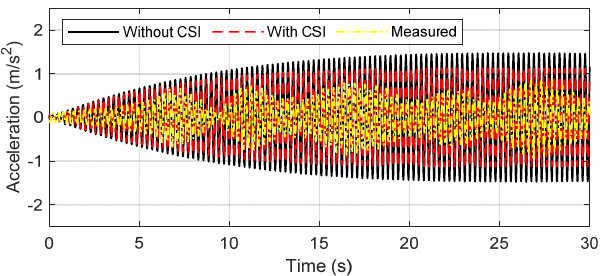
Figure 8. Comparison of predicted and measured mid-span acceleration.